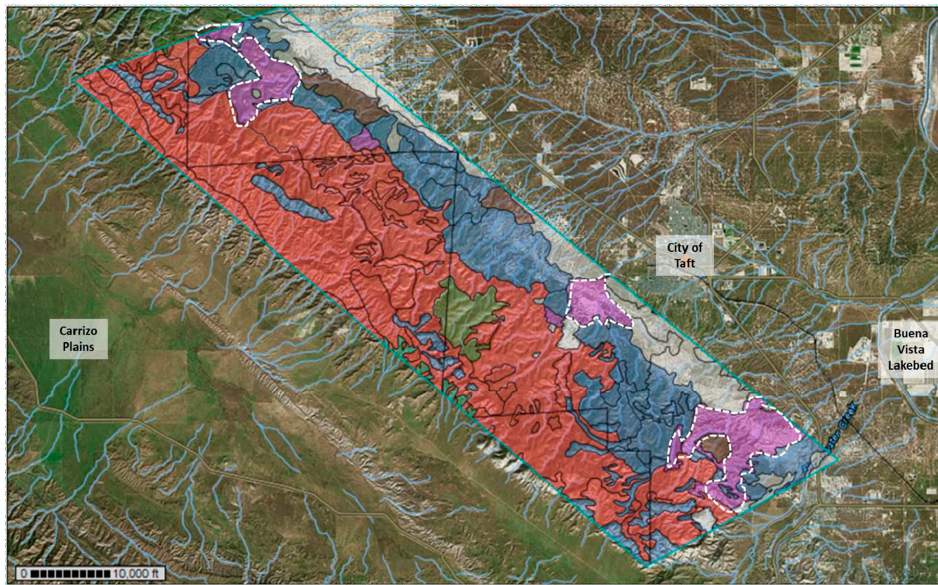
Figure 8. Map of the Temblor SRMA showing the extent of different soil types: Beam–Panoza–Hillbrick complex (red), Pyxo–Cochora–Badlands association (dark blue), Xeric Torriorthents– Badlands (light blue), Littlesignal–Cochora association (magenta), Reward channery loam (kaki), Elkhills–Welport association (grey), Elkhills–Pyxo association (brown), Padres sandy loam (green). Soils of the less abundant Xerorthents–Badlands association are not seen in this overview. The white dashed lines circle soils of the Littlesignal–Cochora association, which of all dominant soil types was the one with the least amount of Coccidioides- positive soil samples.